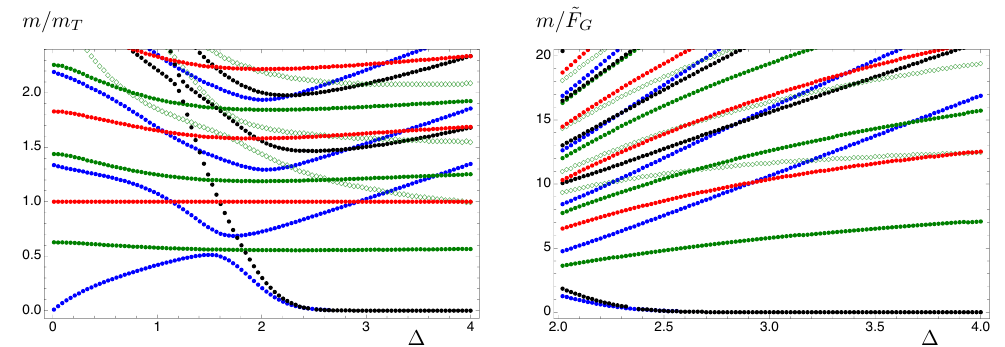
Figure 3 . Example A. Spectrum as a function of ∆ for g 5 = 5 , ˜ σ = 2 , r 1 = 0 , r 2 = 8 . The left panel is normalized to the mass m of the lightest tensor, while the right panel is normalized to T the decay constant ˜ F = F . The colour coding is: scalar (blue), tensor (red), pseudoscalar G G /N C (black), vector (green), axial-vector (green diamonds).